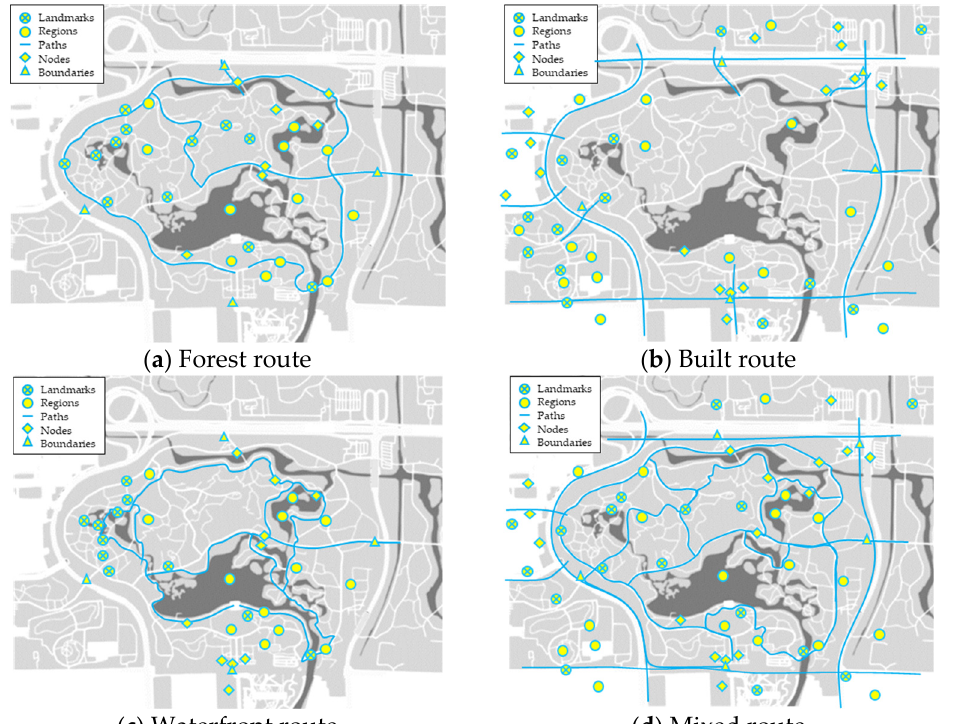
Figure 6. Examples of familiar units in the cognition maps along the four urban forest park routes. 1.